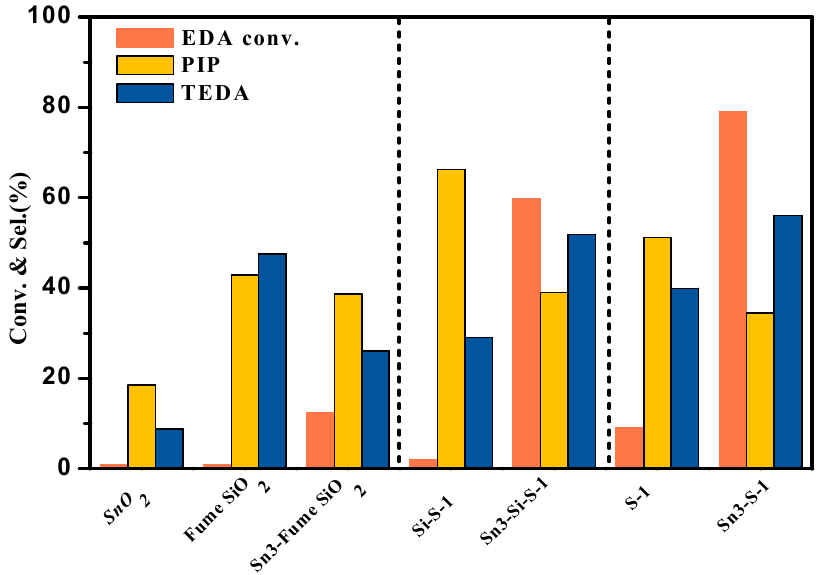
Figure 9. Catalytic performance of different catalysts in the intermolecular condensation of EDA to piperazine (PIP) and 1, 2-Diazabicyclo [2, 2, 2] octane (TEDA) (reaction conditions: 340 °C, EDA/H 2 O mass ratio = 0.9, weight hourly space velocity (WHSV) of reactant solution = 1.3 h − 1 , time on stream (TOS) = 24 h).